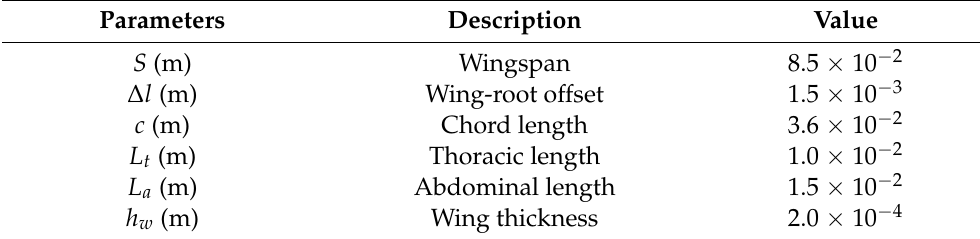
Table 2. Parameters defining the simulation model of the